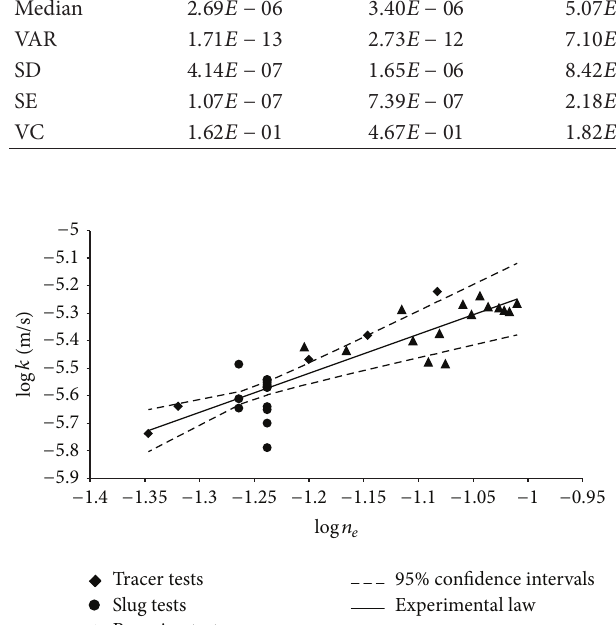
Figure 6: Experimental values of 𝑘 and 𝑛 𝑒 for the different con- sidered field measurement methods and relative best fitting curves representing the 𝑘 = 𝑘(𝑛 𝑒 )